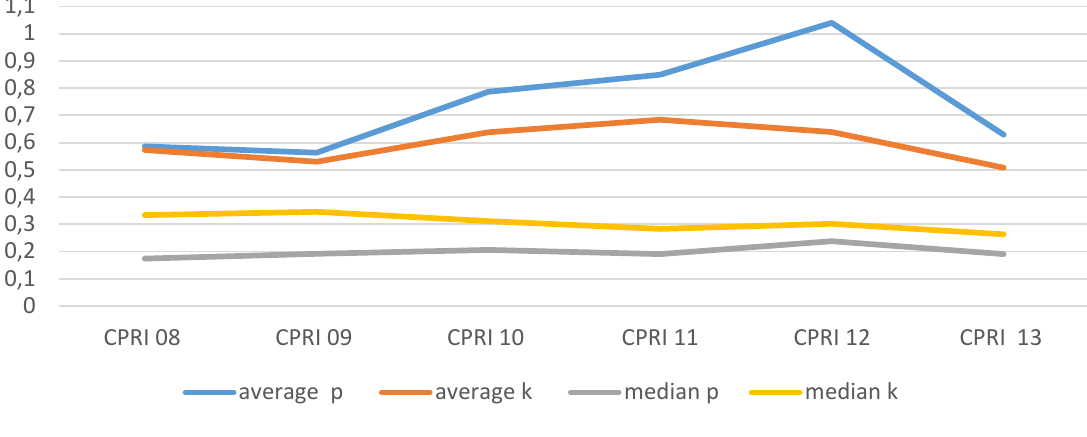
Figure 4. Return on sales